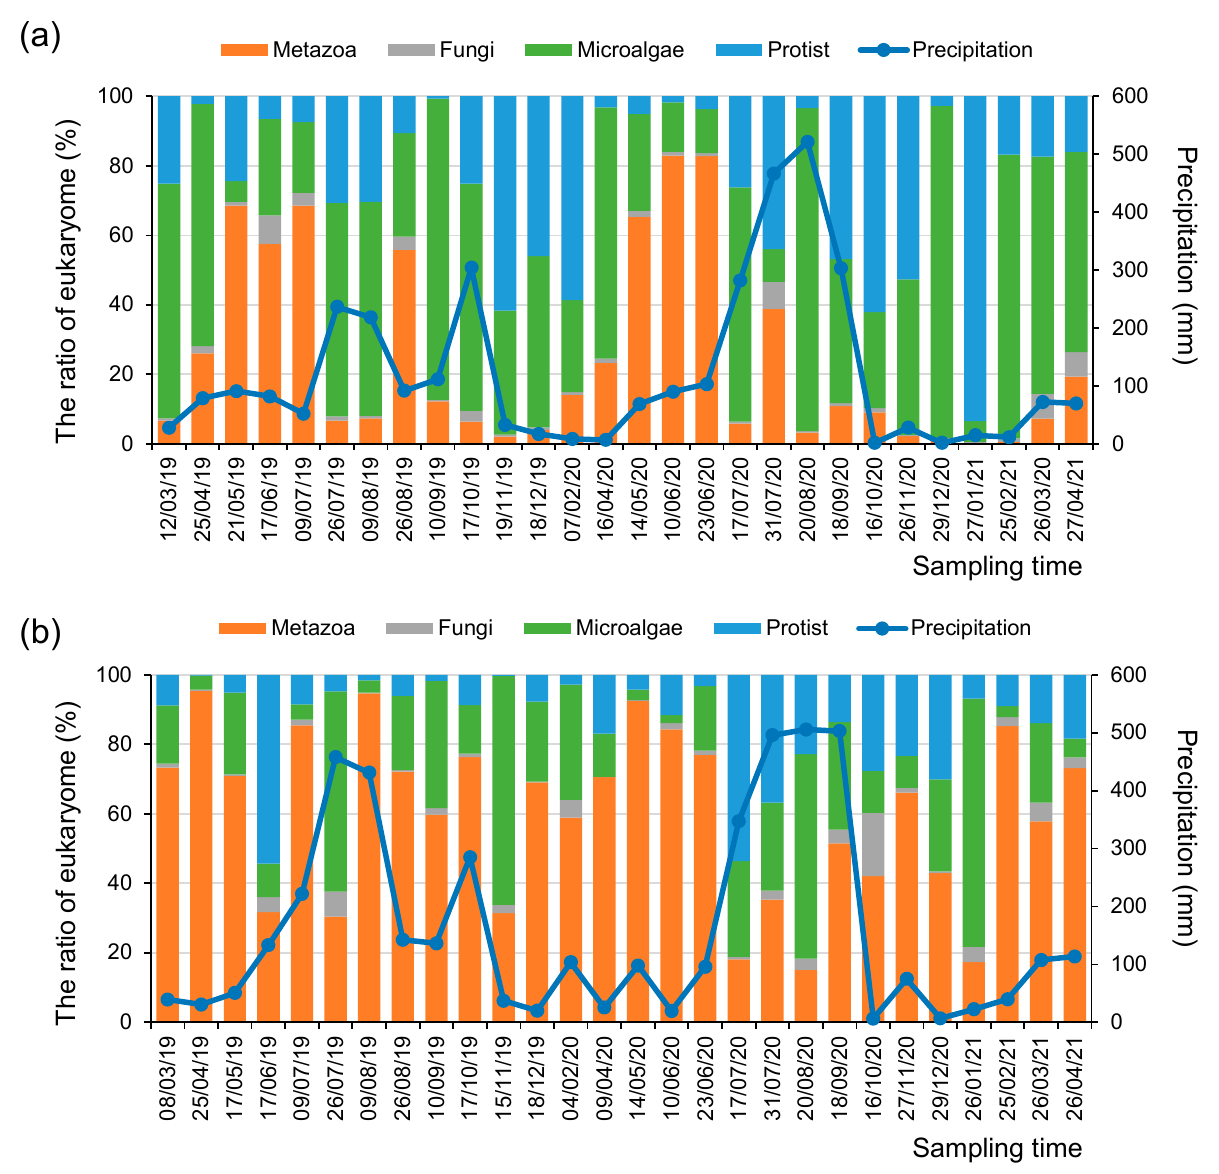
Figure 2. Relative abundance ratios of micro-eukaryotic assemblages and the amount of monthly precipitation (mm) at the ( a ) SJ and ( b ) MG sites during the research periods. Interestingly, at both the SJ and MG sites, the number of taxa determined using the Physicochemical factors are generally considered to be one of the primary causes of eDNA metabarcoding assessments increased significantly with the increment in monthly compositional changes in micro-eukaryotic assemblages in freshwater ecosystems [38]. precipitation (i.e., the accumulated precipitation within 30 days before the sampling time), irrespective of the taxonomic groups assessed (i.e., metazoan, fungi, microalgae, and protozoa) (Figures 3, S3 and S4). In particular, the number of detectable taxa was especially elevated when the monthly precipitation was higher than 200 mm. These results could be attributed to various reasons during the rainy season. First, heavy rainfall can induce the inflow of a higher quantity of eDNA from riparian areas, including soil-based eDNA, into rivers or catastrophic drift of organisms. Therefore, more diverse taxa could be detected through meta-barcoding analyses of the sampled water [40–42]. Second, heavy rainfall abruptly changes water discharge and depth; therefore, even the eDNA derived from benthic species could be more easily detectable in the sampled water